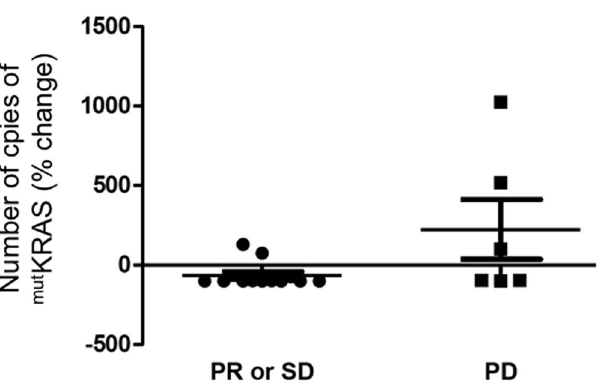
Figure 2. Plot showing early mut KRAS cftDNA variations (% change in number of copies) in patients with PR or SD vs .